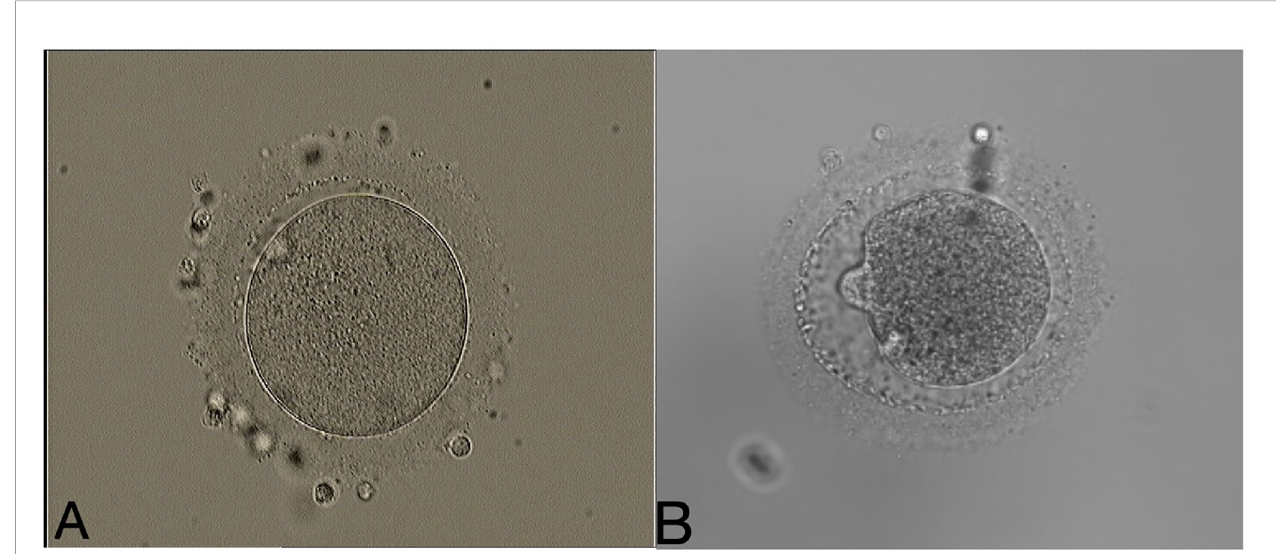
FIGURE 1 | Example images of a matured oocyte (MII oocyte), and degenerated oocyte after ICSI. (A) A matured oocyte (MII oocyte). (B) Degenerated oocyte after ICSI. (200×magni fi